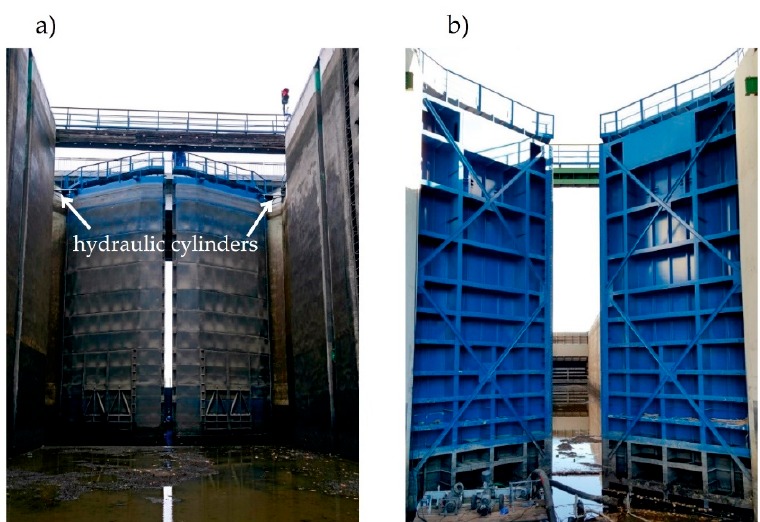
Figure 2 . General view of the Wloclawek lock bottom miter gates. ( a ) From the side of the lock; ( b ) From the side of downstream.